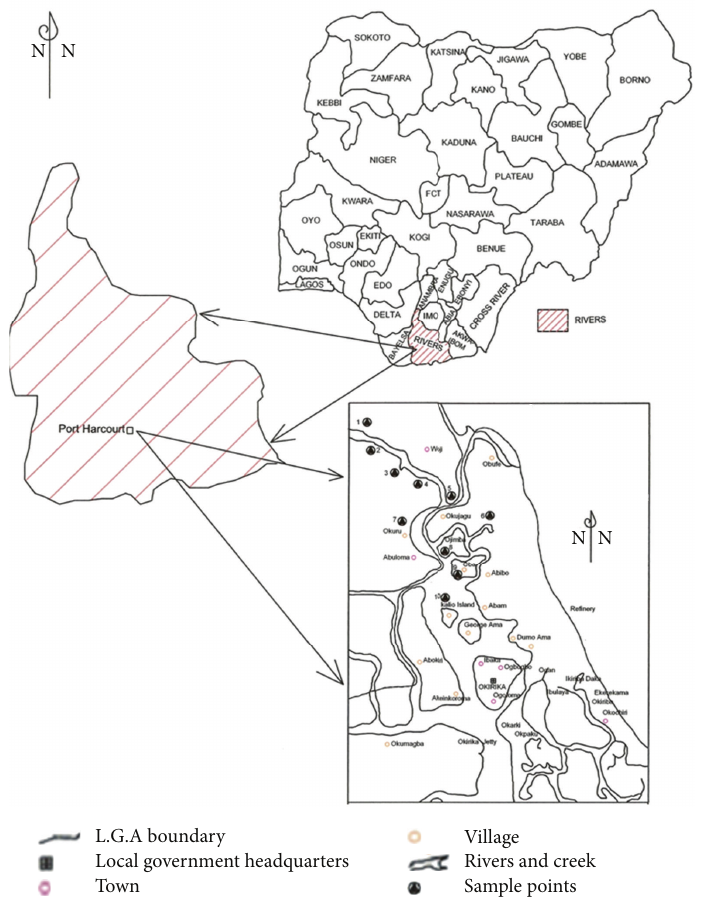
Figure 1: Study area